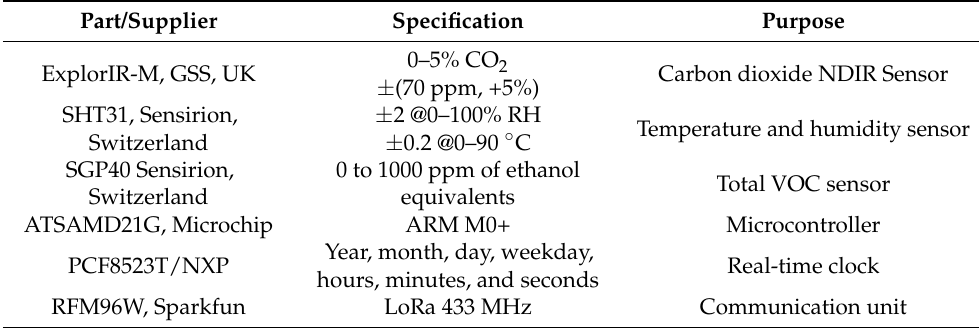
Table 1. Main components used in the sensor probe.